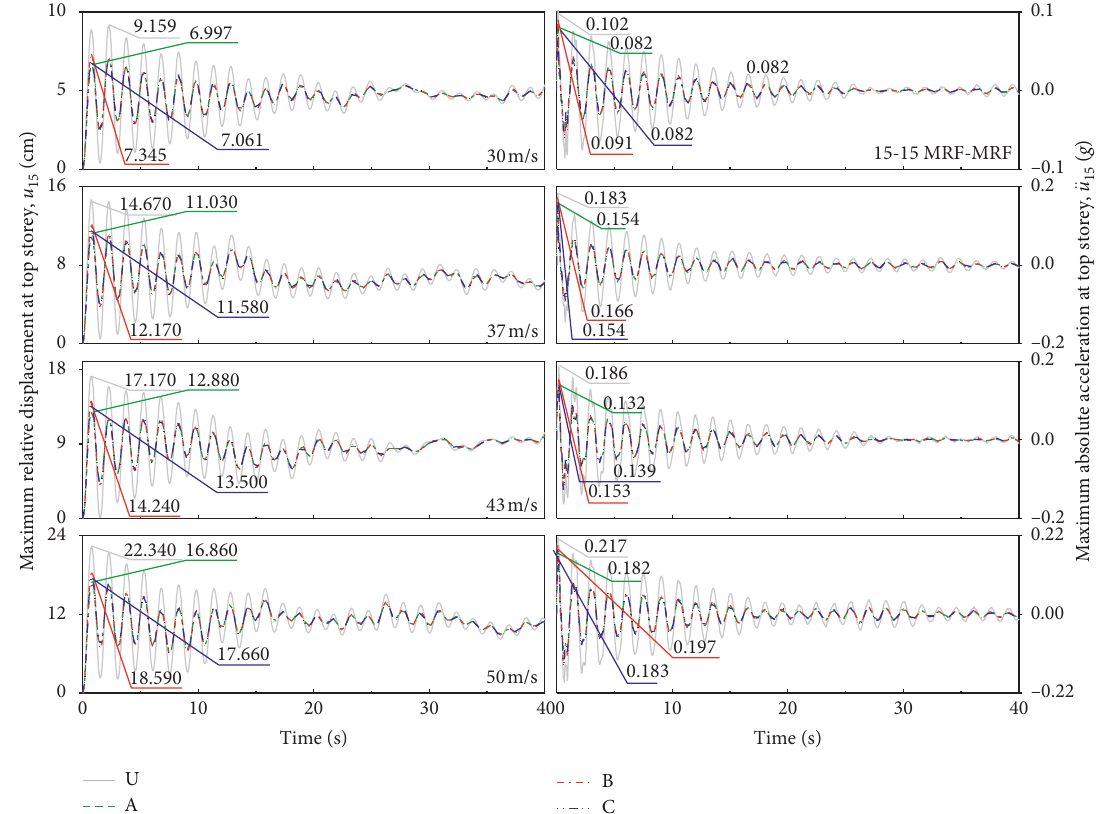
Figure 7: Time history response of top floor displacement and acceleration of connected steel 15-15 MRF-MRF buildings under different wind gust